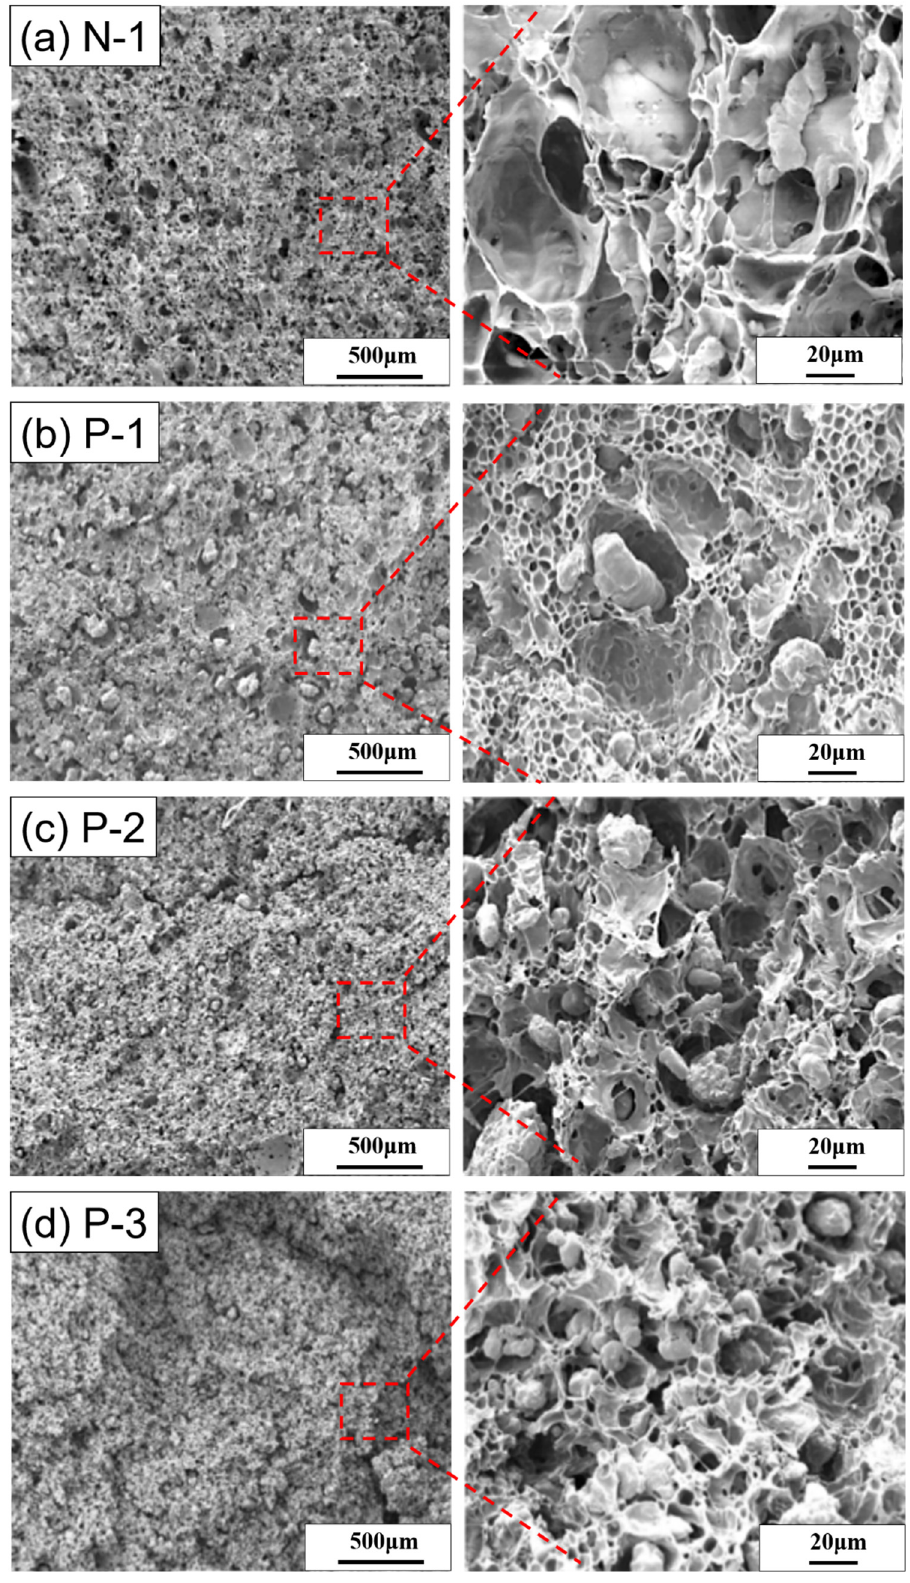
Figure 3. SEM images of cell structure of ( a ) [N-1], ( b ) [P-1], ( c ) [P-2], and ( d ) [P-3] at the foaming temperature of 95 °C and the foaming pressure of 17 MPa.